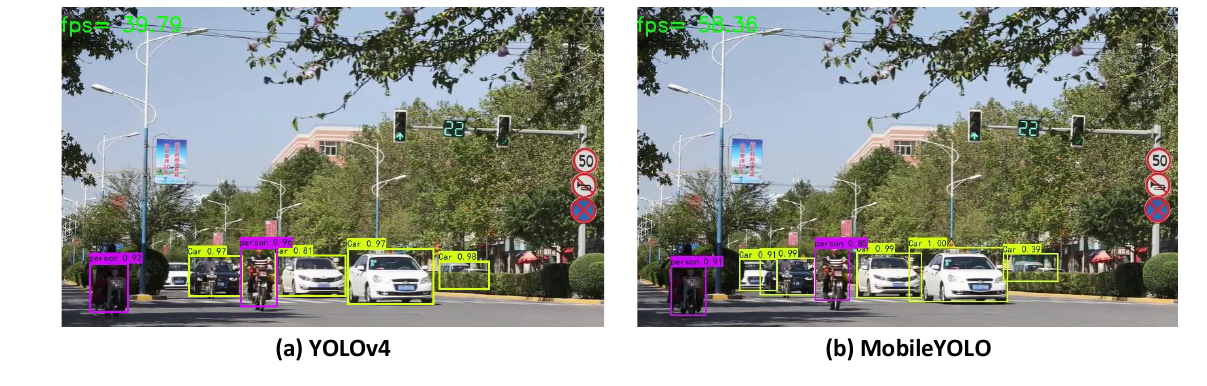
Figure 10. Video detection